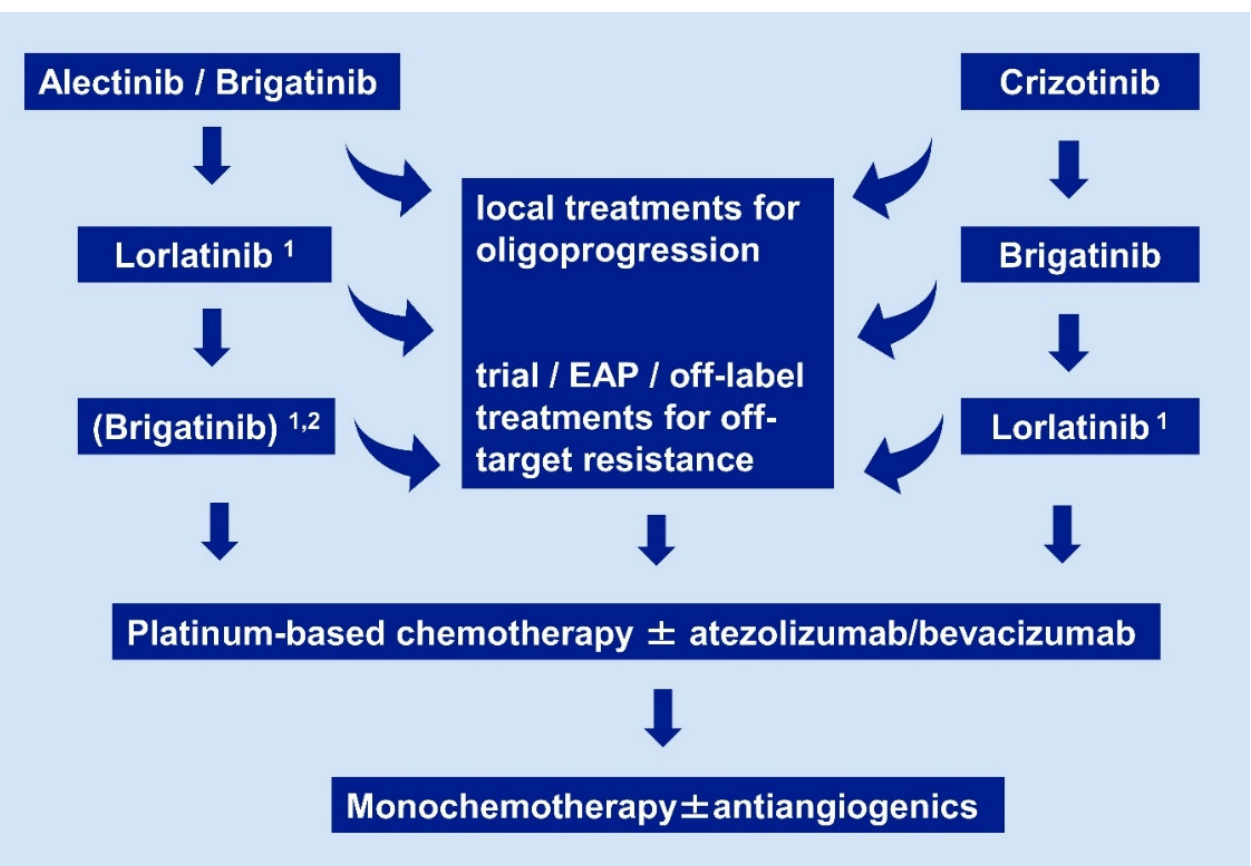
Figure 2. Current algorithm for sequential use of systemic pharmaceuticals in ALK + NSCLC. Details and the rationale are given in Sections 2.1–2.5. Footnotes: 1 if no ALK mutation is detectable by molecular analysis of tissue or liquid rebiopsies, close monitoring with short-term restaging after ≤ 6 weeks is warranted, in order to ensure timely switch to chemotherapy if there is no response; 2 a trial of brigatinib after lorlatinib for patients who did not receive brigatinib as first-line treatment in order to prolong chemotherapy-free time, based on the results of the international EAP, with a median duration of treatment 7.5 months for the lorlatinib-pretreated cohort [70]. EAP: extended access program.